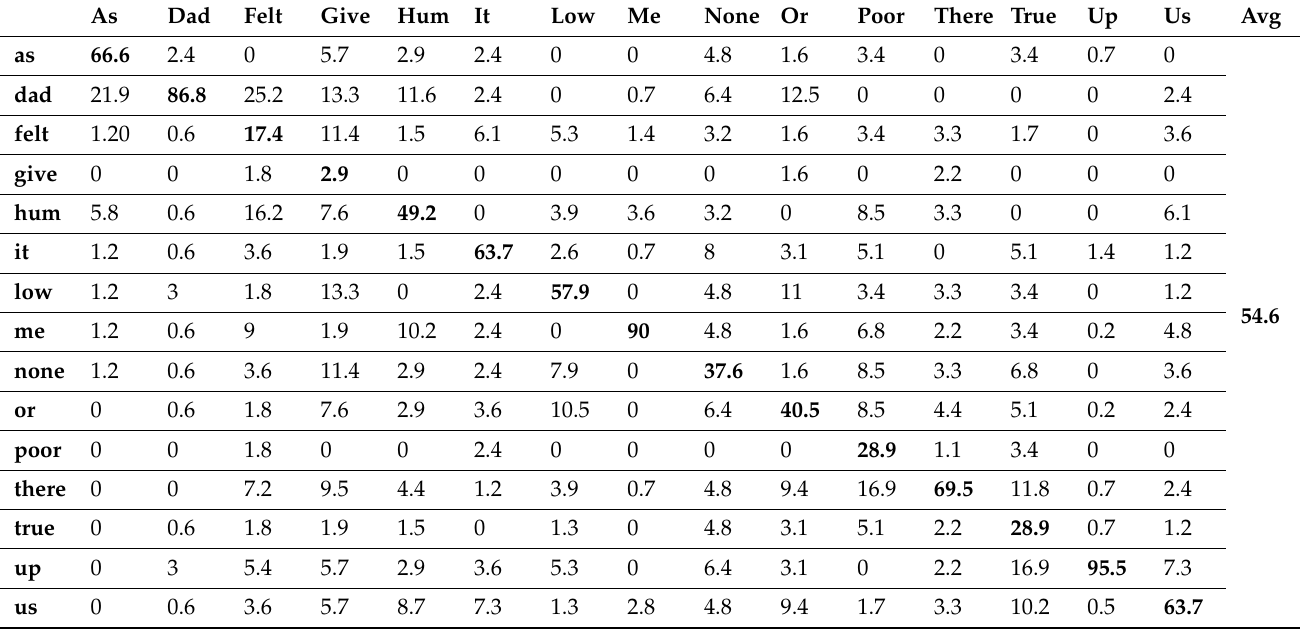
Table 3. Confusion matrices of noises predictions for NN